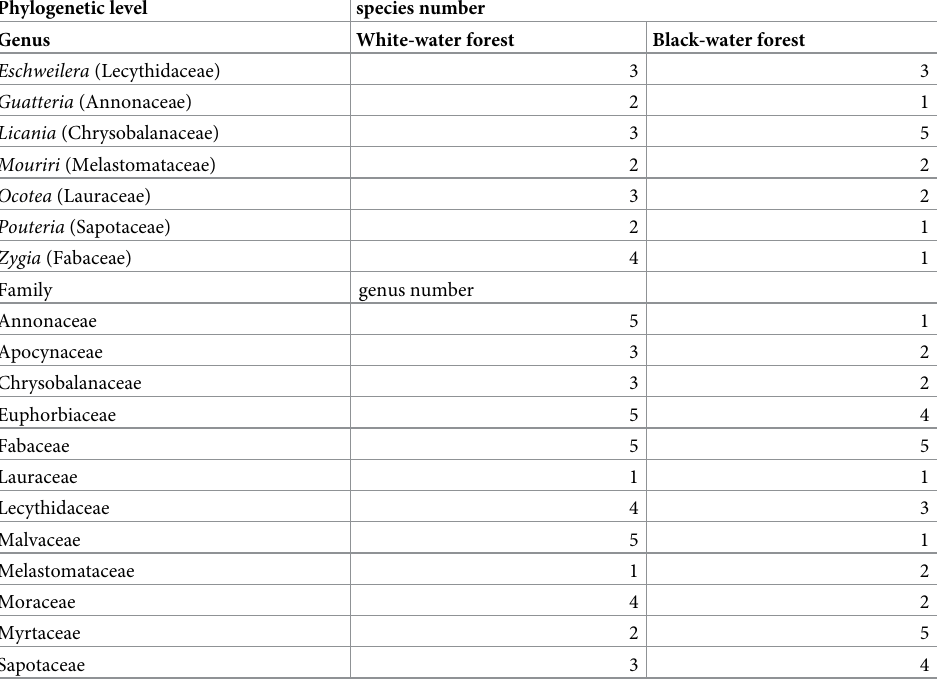
Table 1. Seven genera and 12 families of the study. The columns indicate the genus/family, and the species/genus number belonging to each genus/family in white-water and black-water forests. The number of individuals sampled for each genus/family per forest type is 5 (n =